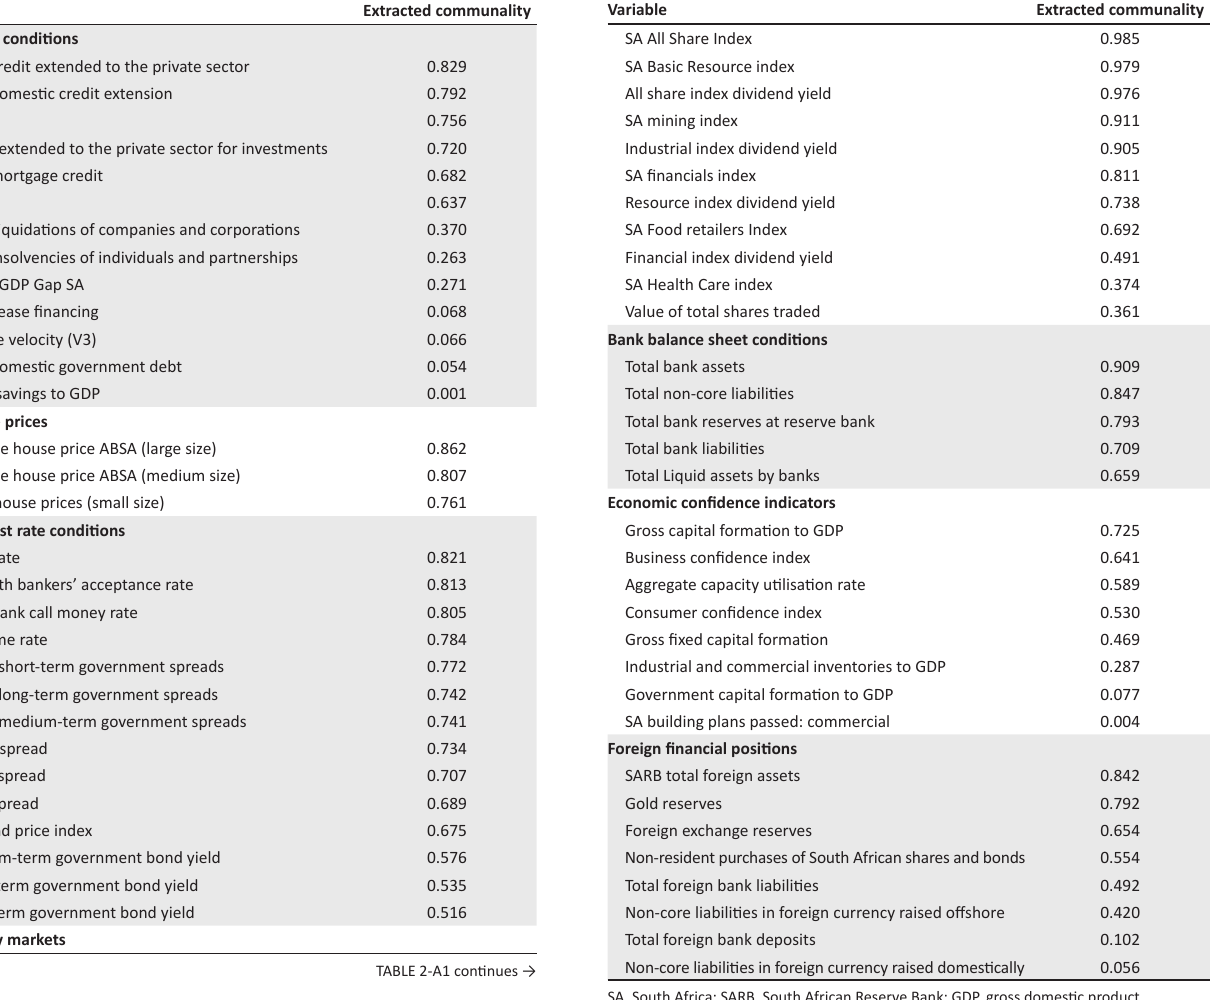
TABLE 2-A1 (continues...): Extracted communalities.